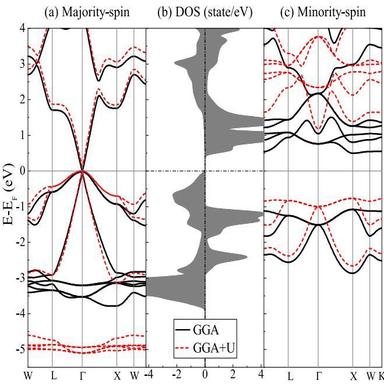
Spin-resolved band structure and total density of states of HH-MnPK in b-phase at optimized lattice constant. The dashed red lines represent the band structure obtained from GGAþU exchange-correlation approximation. (For interpretation of the references to colour in this figure legend, the reader is referred to the Web version of this article.)